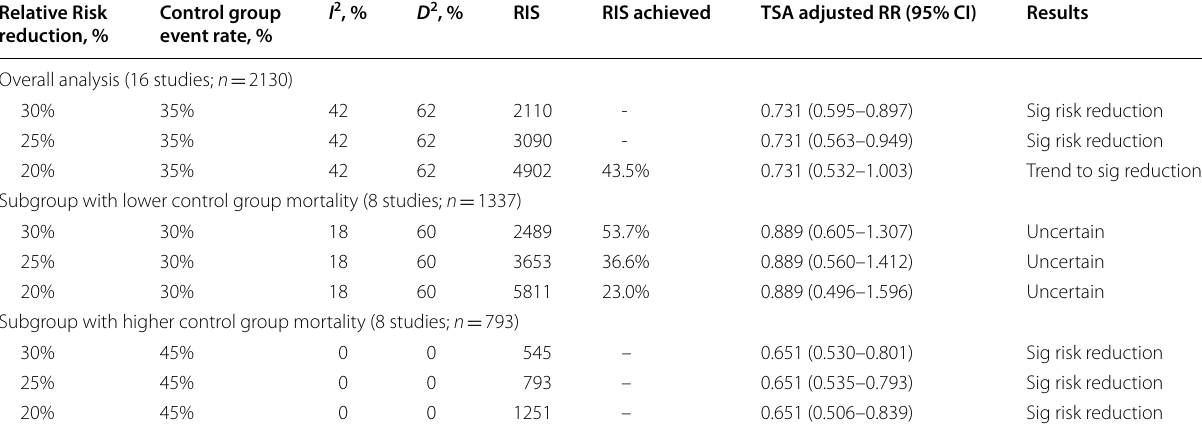
DerSimonian–Laird Random effect model, Alpha 5%, beta 10% RIS required information size, TSA Trial sequential analysis